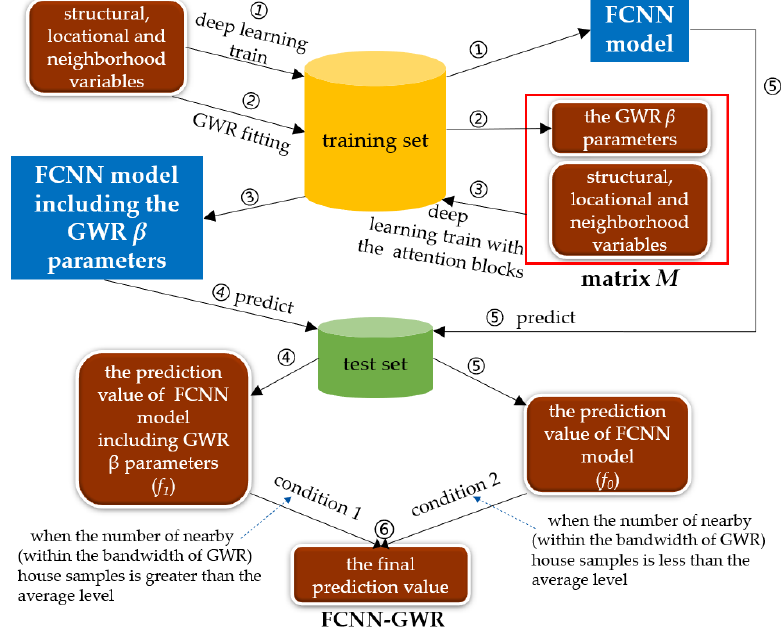
Figure 3. The procedure of the FCNN–GWR model.